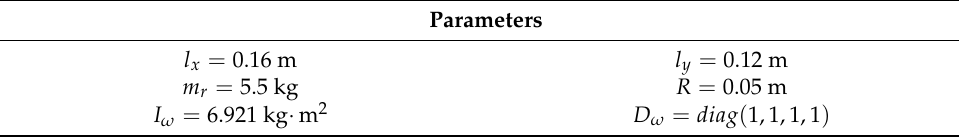
Table 2. Physical parameters.